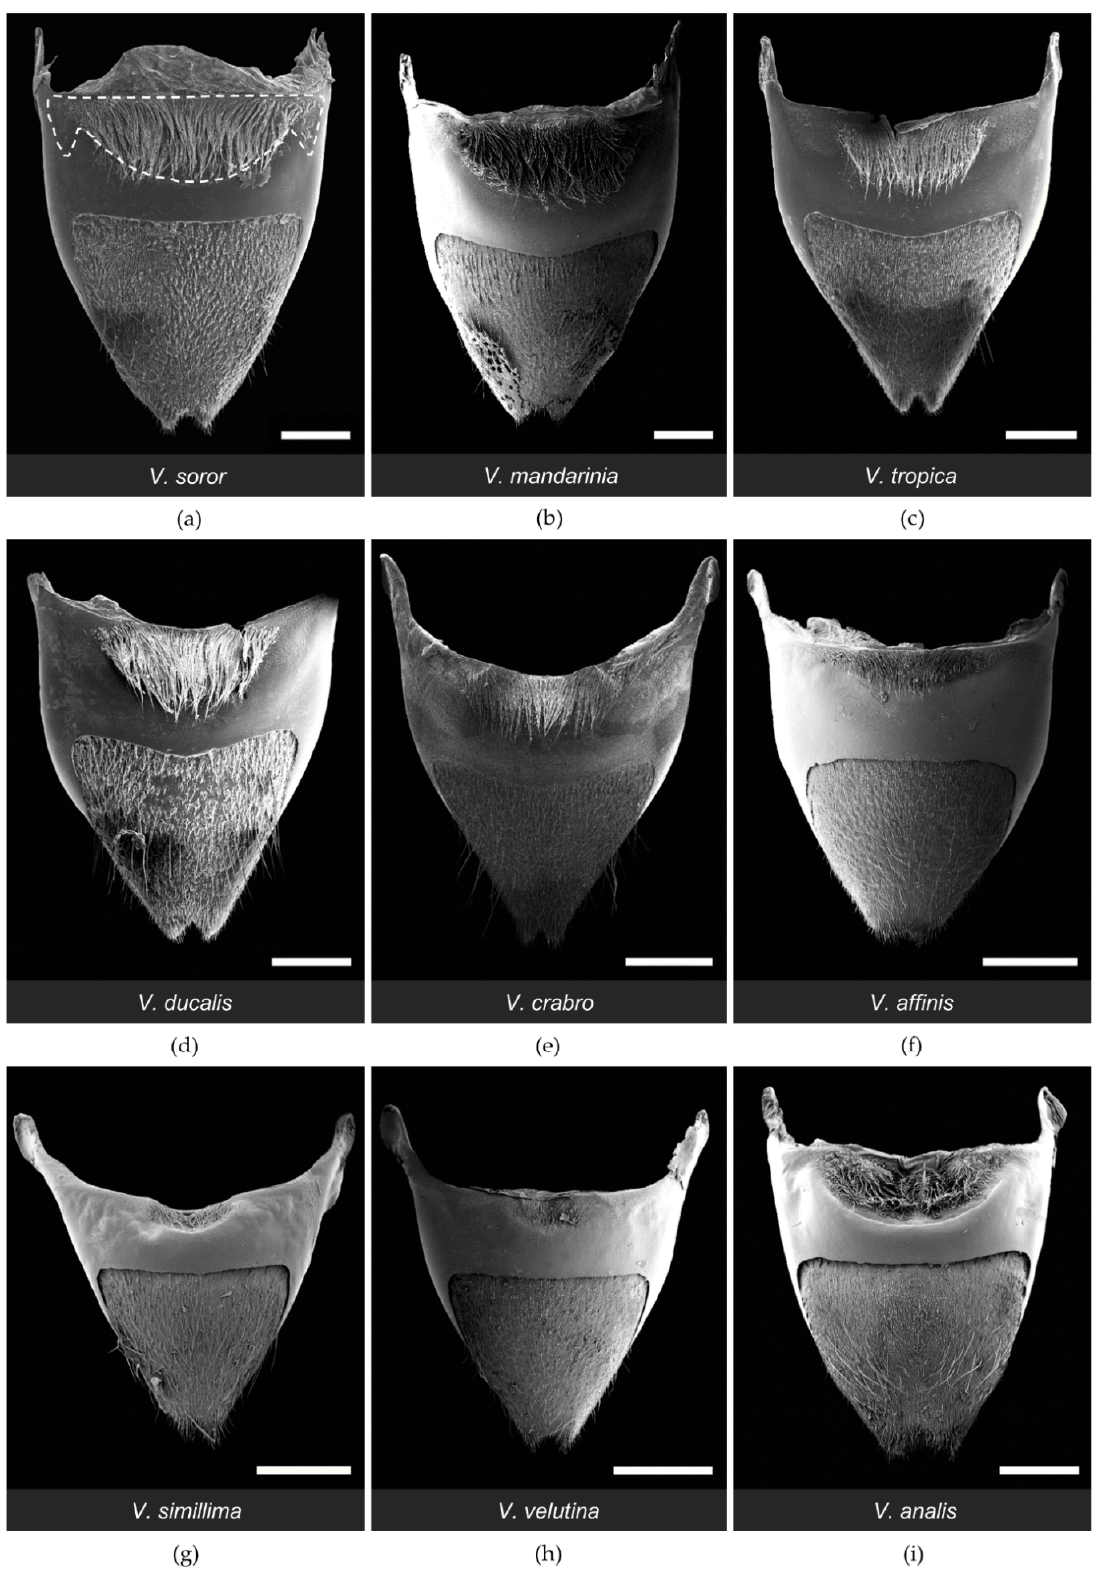
Figure 2. SEM images of the sixth metasomal sternite and van der Vecht gland of nine Vespa species ( a–i ). Anterior is at the top. Species are presented in the order in which they appear in the phylogeny depicted in Figure 1. Lateral pore clusters and the hyaline region with the sternal brush are outlined by a dashed white line in ( a ). Bars indicate 1 mm for scale.